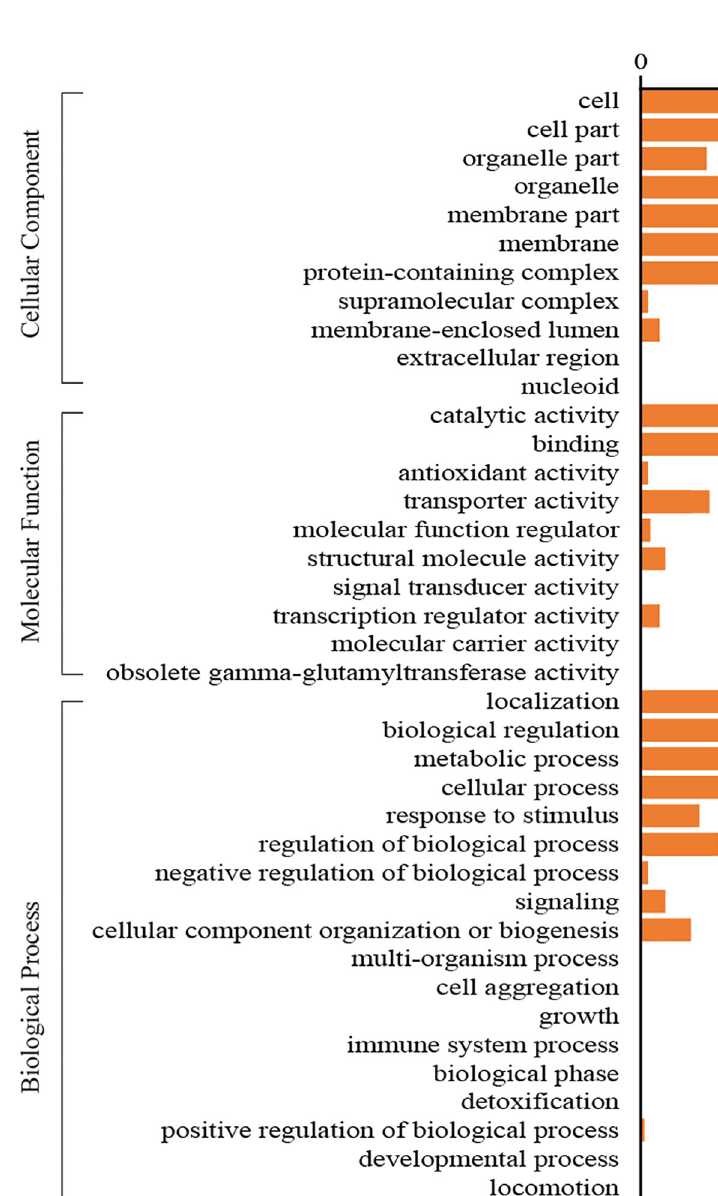
Frontiers in Microbiology |